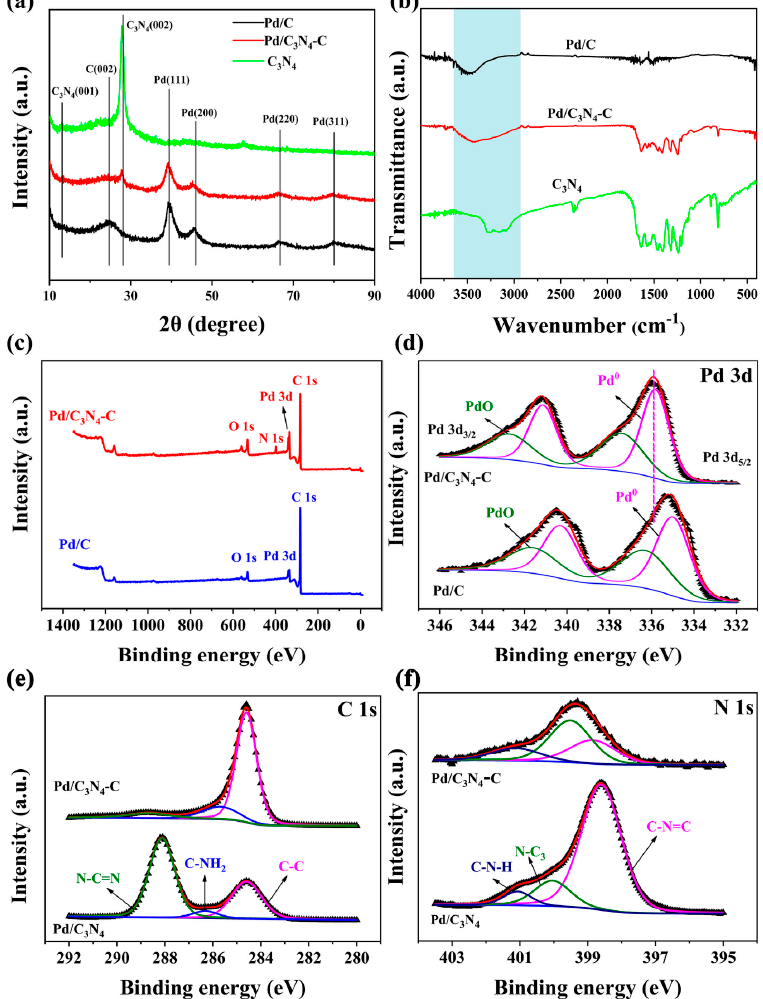
Figure 3. ( a ) XRD patterns and ( b ) FTIR spectra of Pd/C 3 N 4 -C, Pd/C, and C 3 N 4 catalysts. ( c ) XPS full spectra of Pd/C and Pd/C 3 N 4 -C, ( d – f ) XPS spectra of Pd 3d, C 1s, and N 1s.